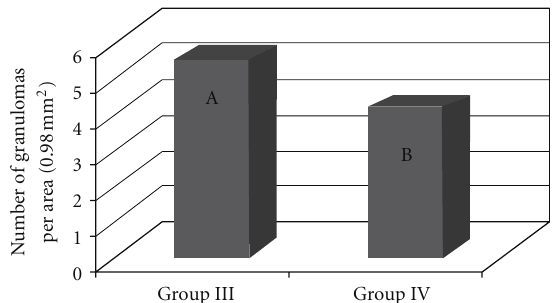
Figure 10: The number of granulomas in the liver of the mice that were previously infected with the S. mansoni BH strain and then inoculated 8 weeks later with eggs from the S. mansoni BH (Group III) or SJ (Group IV) strains. The means depicted with di ff erent letters di ff er significantly ( α = 0 . 05).